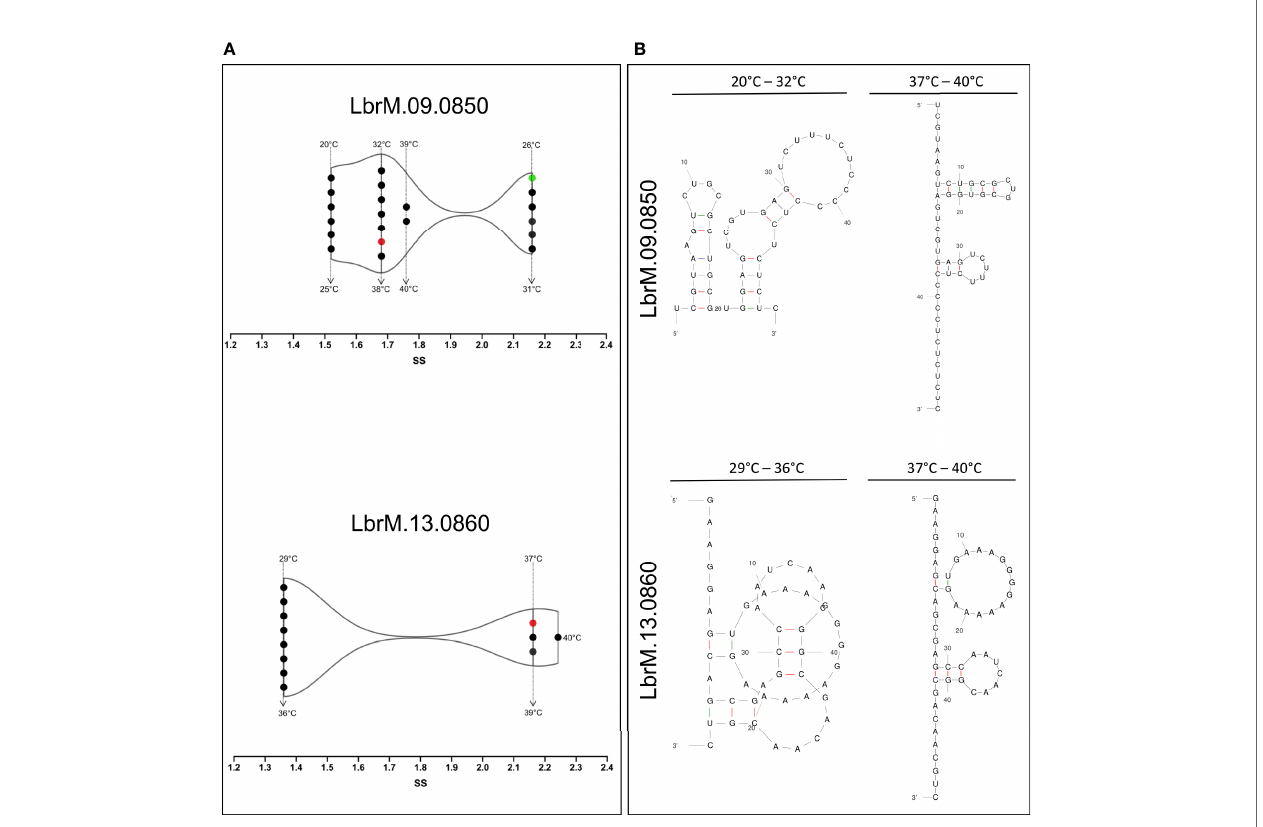
FIGURE 6 | Temperature kinetics of secondary structure modulation of 3 ’ -untranslated region of mRNA sequences of L. (V.) braziliensis . (A) The temperature- based modulation event was done by single-stranded (SS) frequency measures of the OPB (LbrM.09.0850) and S13 (LbrM.13.0860) gene 3 ’ -UTR of mRNA sequences. The single-stranded structures (ss) were assessed at different temperatures ( (cid:129) ). The red symbol represents the mammalian temperature at 37°C and in green the sand fl y vector temperature at 26°C. (B) Different types of 3 ’ -UTR of mRNA sequences secondary structures, representative of the modulation events in different temperature